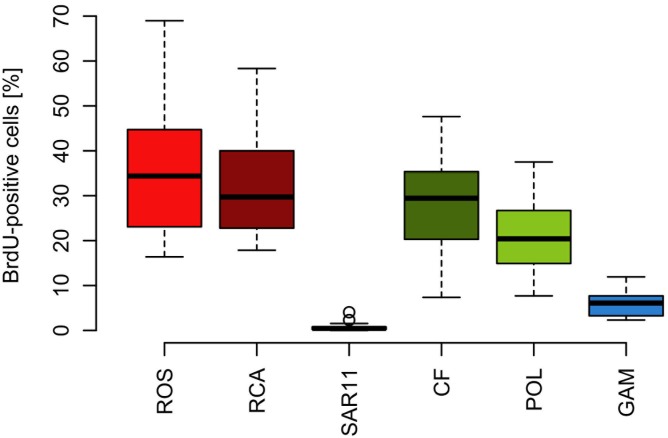
Box-Whisker plots of the percentage of BrdU-positive cells within the Roseobacter group and its RCA cluster, the SAR11 clade, Bacteroidetes (CF) and its Polaribacter cluster and Gammaproteobacteria assessed by CARD-FISH during early summer in the North Sea between 54° and 58°N. Given are means, the 25 and 75% percentiles and the error bars of 5 and 95%. The two circles of the SAR11 clade are values above the 95% percentile.